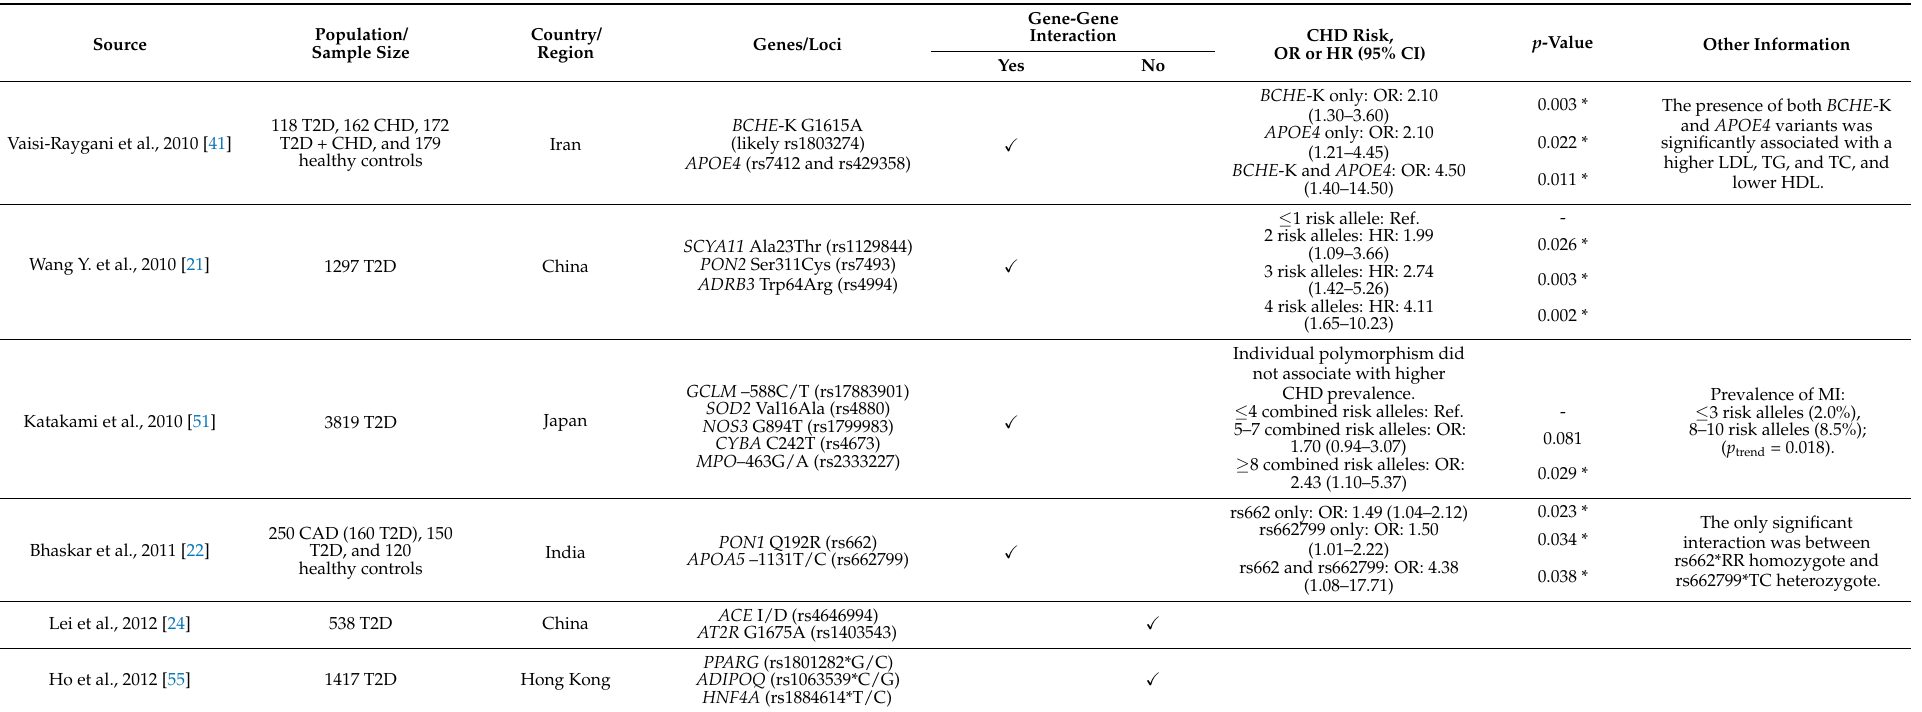
Table 2. Gene-gene interactions and their associations with CHD in T2D